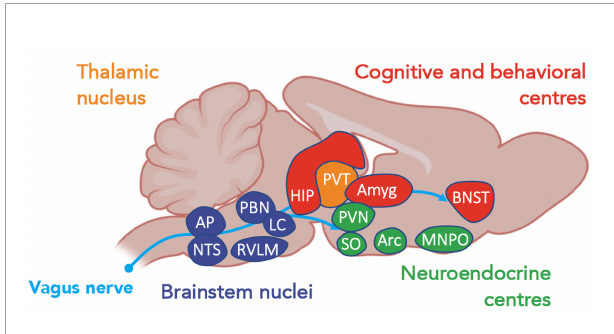
FIGURE 2 | A schematic view of centers, according to their functions, activated during a systemic in fl ammatory response (37). Amyg, amygdala; AP, area postrema; Arc, arcuate nucleus; BNST, bed nucleus of the stria terminalis; HIP, hippocampus; LC, locus coeruleus; MNPO, median preoptic nucleus; NTS, nucleus of tractus solitarius; PBN, parabrachial nucleus; PAG, periacqueductal gray; PVN, paraventricular nuclei; PVT, paraventricular nuclei of the thalamus; RVLM, rostral ventrolateral medulla; SO, supraoptic